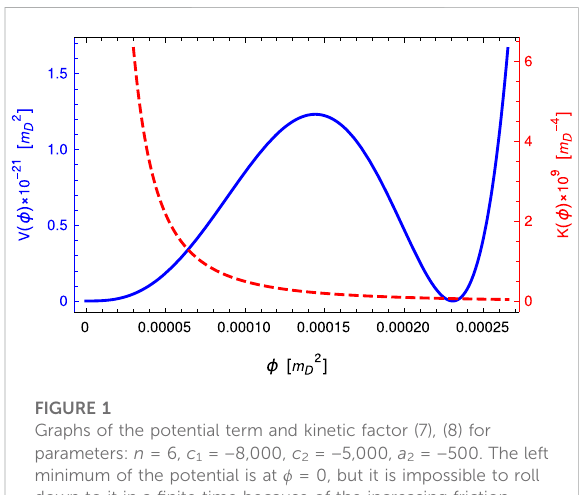
FIGURE 1 Graphs of the potential term and kinetic factor (7), (8) for parameters: n = 6, c 1 = − 8,000, c 2 = − 5,000, a 2 = − 500. The left minimum of the potential is at ϕ = 0, but it is impossible to roll down to it in a fi nite time because of the increasing friction effectofthekineticfactor, therightminimumisat ϕ min =2.3 · 10 – 4